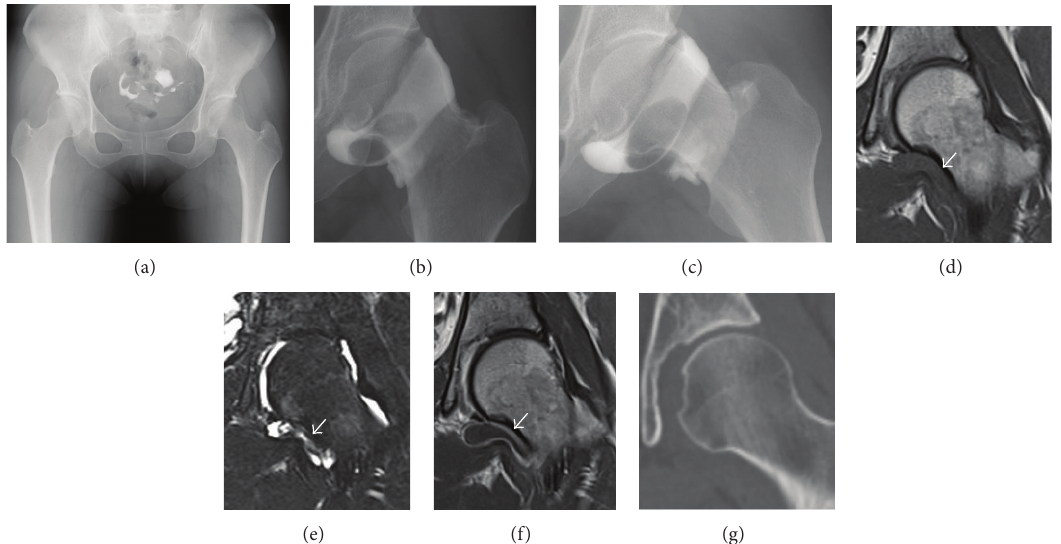
Figure 1: (a) An initial anterior radiograph shows no significant findings. (b, c) Enhanced stress radiographs reveal a mobile intra-articular mass. (d–f) Magnetic resonance images: (d) a coronal T 1 -weighted image shows a low-intensity mass lesion located inferior to the hip joint; (e) a coronal short 𝜏 inversion recovery sequence shows a mass with both low- and high-intensity areas; (f) a coronal enhanced T 1 -weighted image shows marginal enhancement of the mass. (g) Computed tomography image shows erosive changes on the fossa acetabuli and enthesis of the ligamentum teres of the femur.